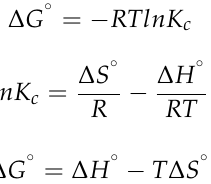
presented in Table